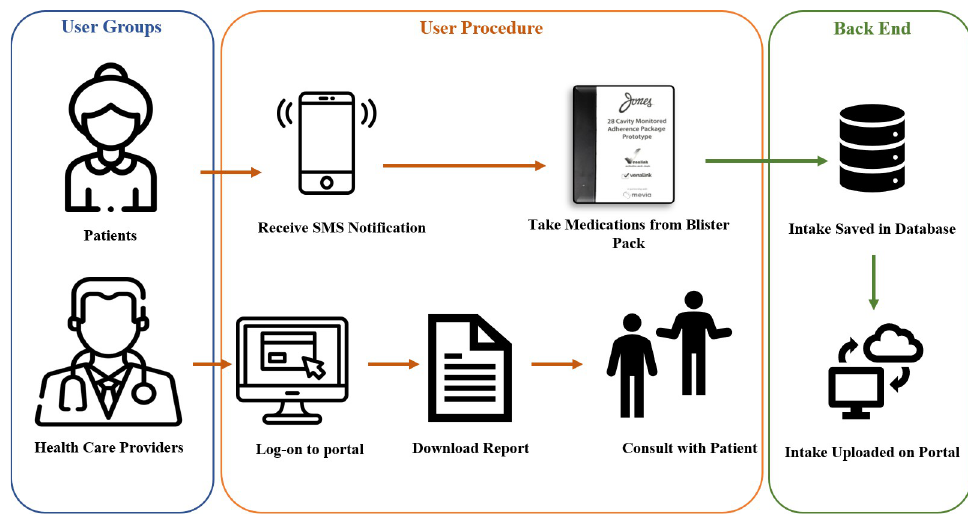
Fig 2. Utilizing smart multidose blister